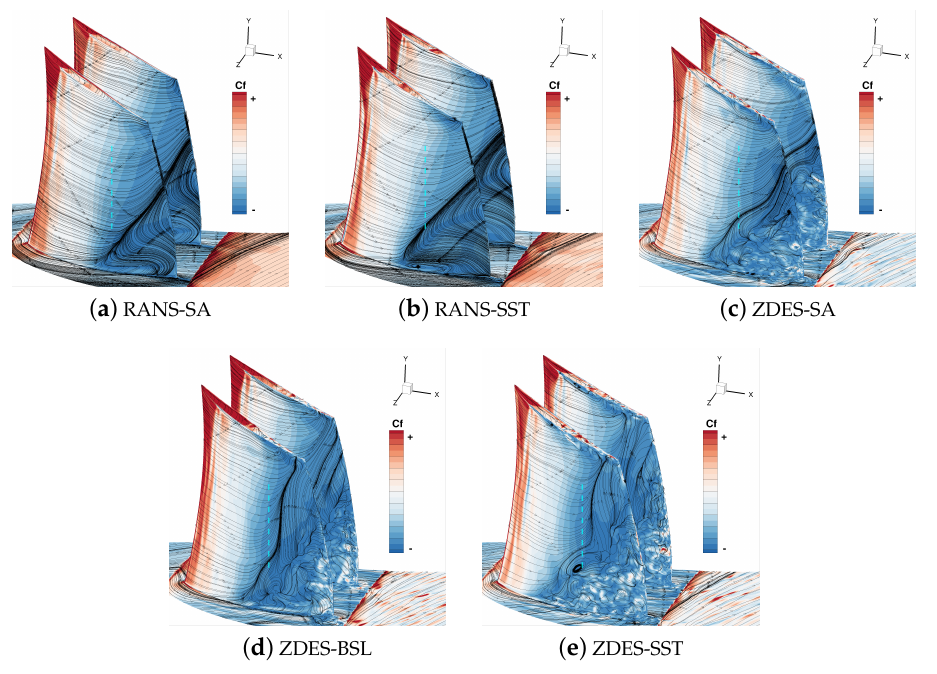
Figure 13. Skin-friction magnitude and skin-friction lines over hub and rotor blades at t = T /2.